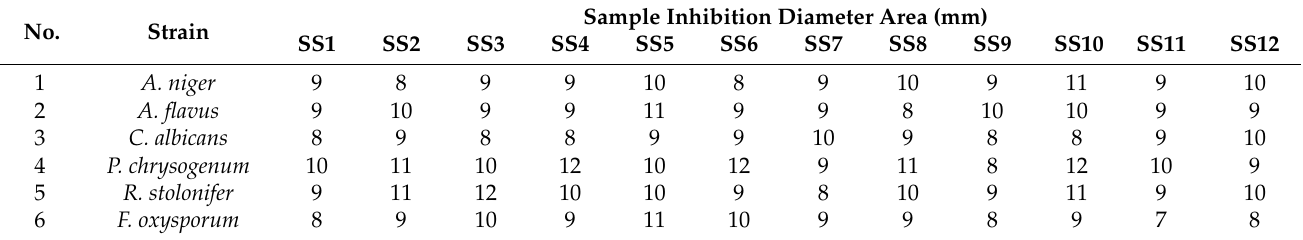
Table 8. Diameters of the inhibition zones on the fungal strains for honey samples from Alba County.